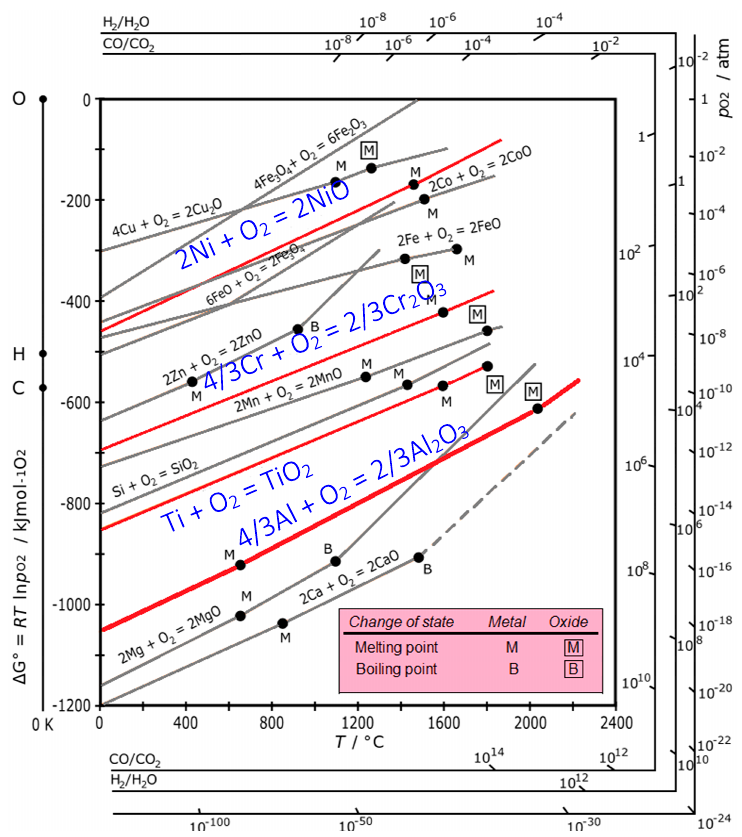
Figure 10. Ellingham diagram, in which the related elements of Ni, Cr, Ti, and Al were marked.